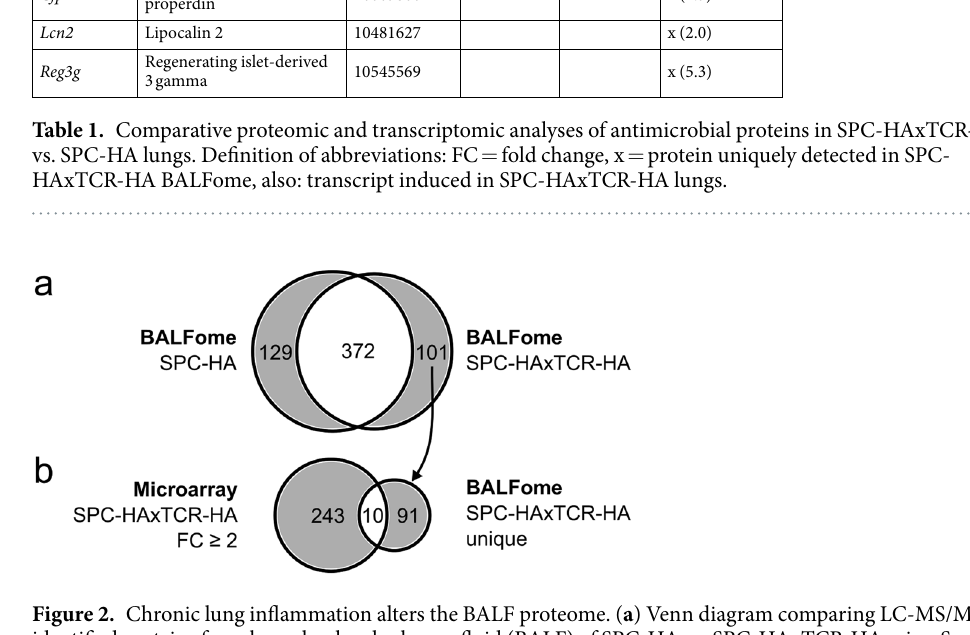
significantly higher mean ODs were detected in BALF samples from SPC-HAxTCR-HA mice (Fig. 3e), confirm- ing amplified active transepithelial transport of SIgA. BALF from chronically inflamed lungs has an increased opsonizing capacity. BALF supernatants and identified antibody-carrying bacteria by surface staining against IgA (Fig. 4a) or IgM (Fig. 4d), respectively. While similar fractions of IgA-positive pneumococci following incubation with both SPC-HAxTCR-HA as well as SPC-HA BALF (Fig. 4b) were observed, significantly higher IgA deposition on pneumococci that were incubated with BALF from SPC-HAxTCR-HA mice was detected (Fig. 4c). Moreover, opsonization with SPC-HAxTCR-HA BALF yielded increased portions of IgM-positive pneumococci as well